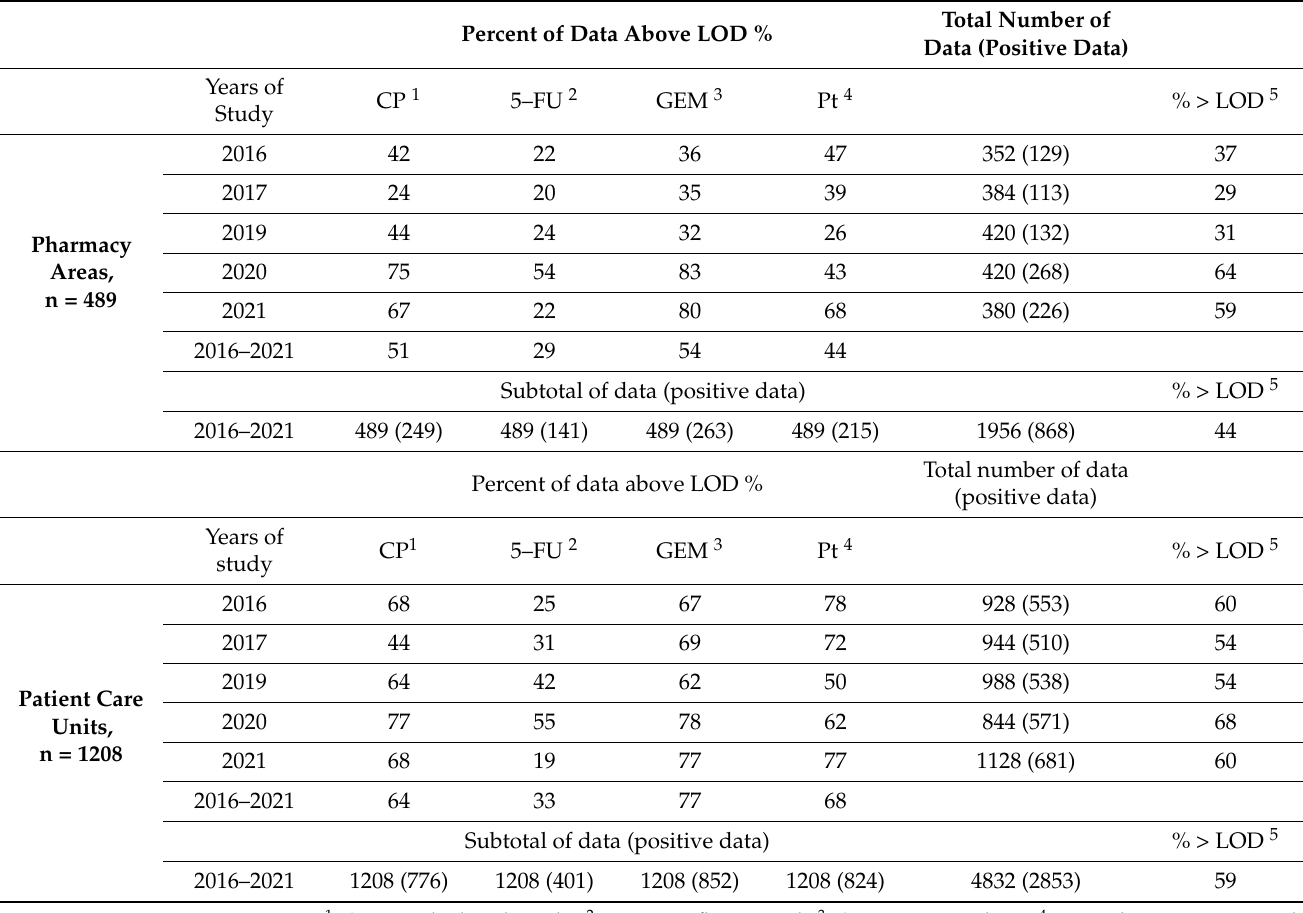
Table 2. Frequency of contamination for each drug throughout the years of study in wipe samples. Percent of Data Above LOD %